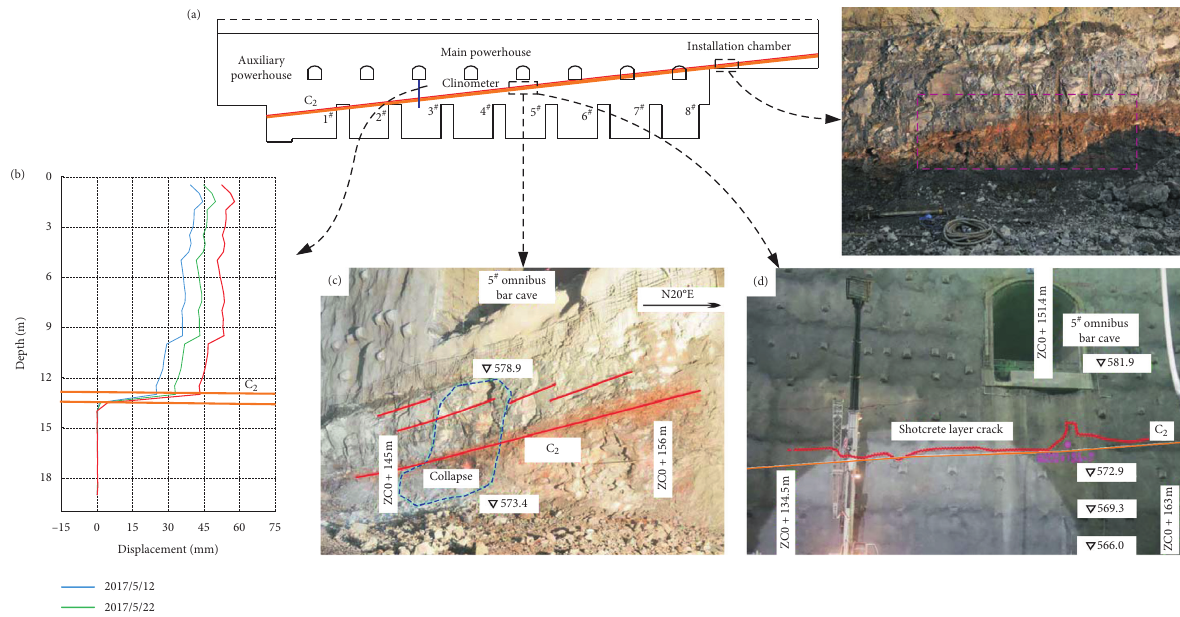
Figure 13: (a) Weak interlayer zone C 2 at the Baihetan underground powerhouse and deformation and failures it caused: (b) shear deformation measured by the clinometer at the 3 # omnibus bar cave, (c) local collapse, and (d) shotcrete layer